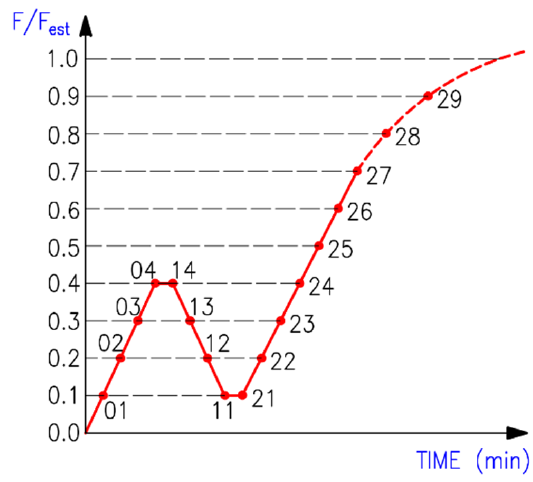
Figure 7. The course of experimental testing.